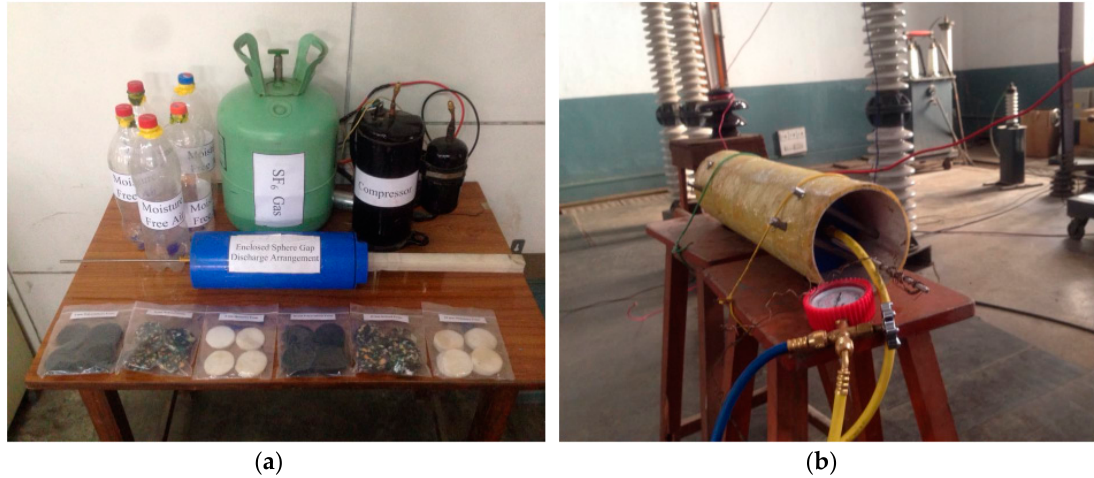
Figure 12. ( a ) Various components used in the experimental setup; ( b ) Lightning impulse and disruptive discharge arrangement at different gas pressures.